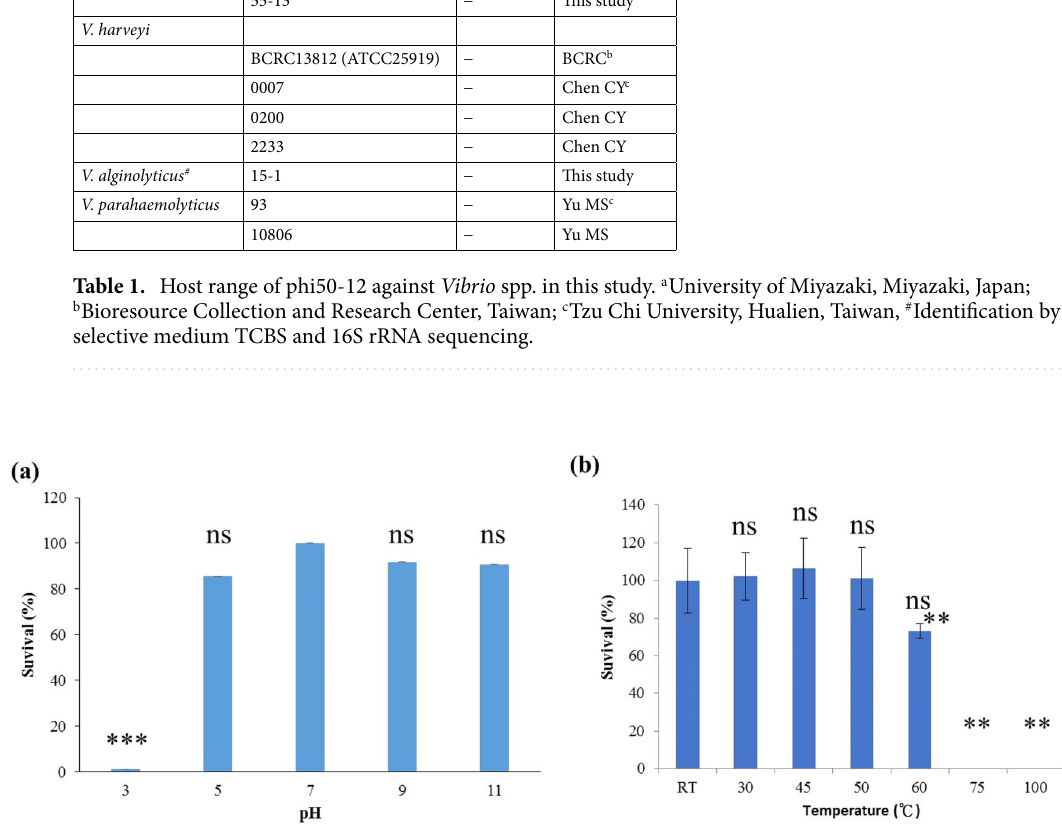
Figure 3. pH and thermal stability of phi50-12. ( a ) 10 6 PFU of phi50-12 were subjected to various pH at 30 °C for one hour and titrated by plaque assay using a double-layer method; ( b ) phi50-12 stability (10 6 PFU) under various temperatures for 1 h was measured by plaque assay. The survival rate was measured by comparison with initial phage number. The experiments were performed in triplicates and the data are shown as the mean ± SEM. Student’s t test was performed for significance. Ns no significance; **p < 0.01; ***p <